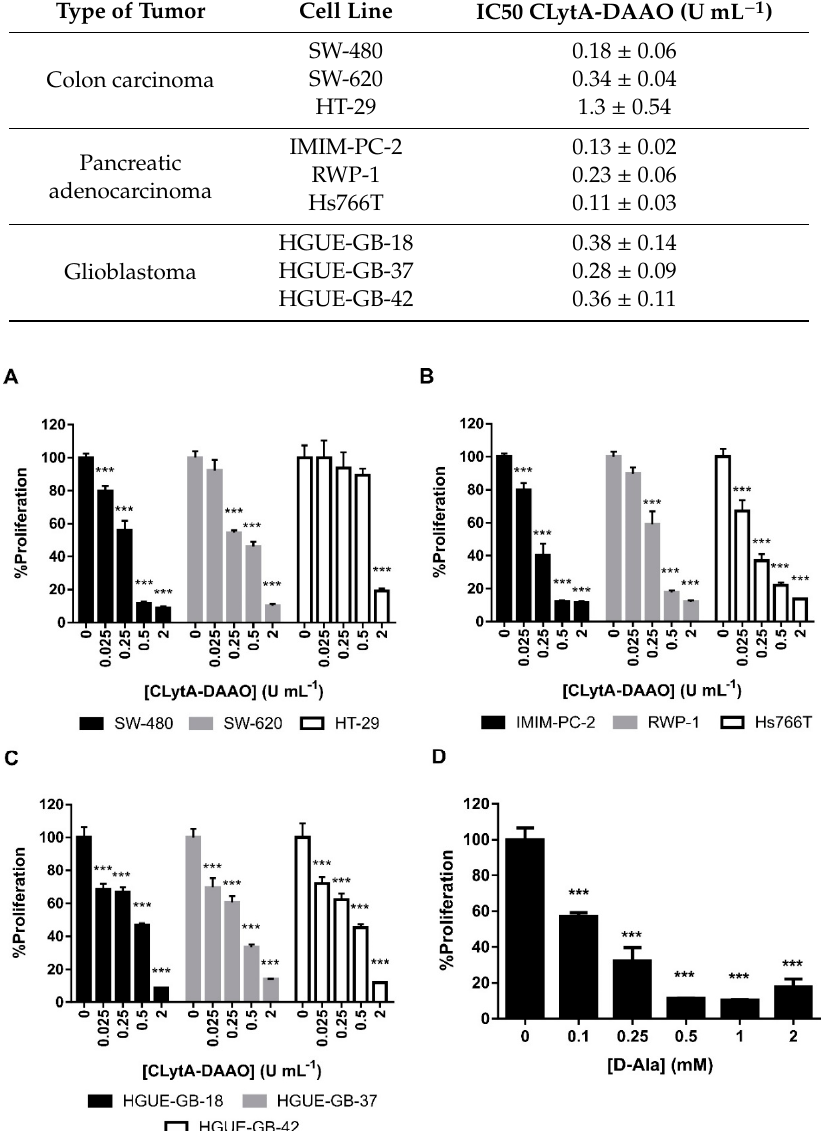
Figure 1. CLytA-DAAO effects on cell proliferation. ( A ) SW-480, SW-620, and HT-29 colon carcinoma Figure1. CLytA-DAAOe ff ectsoncellproliferation. ( A )SW-480, SW-620,